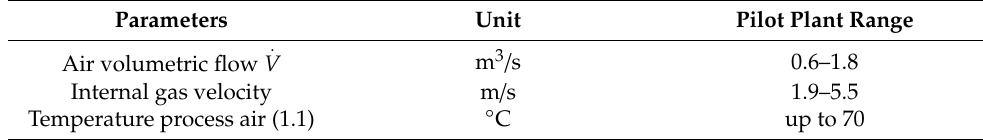
Table 3. Pilot plant operating